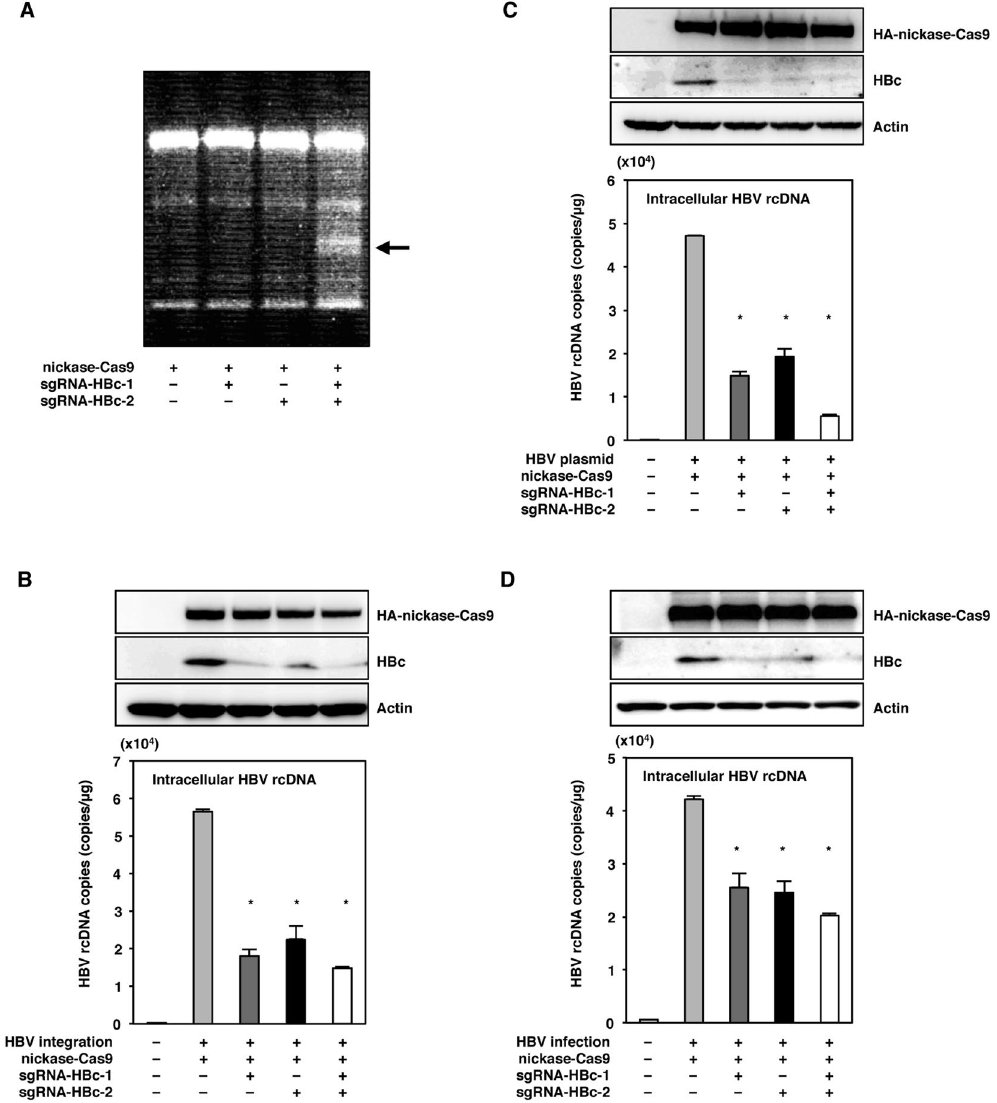
Figure 3. The expression of nickase-Cas9 with either or both of the sgRNAs suppressed the replication of HBV. ( A ) Nickase-Cas9 with sgRNA-HBc-1 and/or sgRNA-HBc2 was lentivirally transduced in HepG2.2.15.7 cells. Total DNA was collected at 5 days post-transduction, and mutations of HBV genome in HepG2.2.15.7 cells were detected by surveyor assay. The arrow indicated the surveyor digestion product. ( B ) HepG2.2.15.7 cells transduced with nickase-Cas9 and the sgRNAs were collected at 5 days post-transduction, and the expression of HBc was determined by immunoblotting. Intracellular HBV rcDNAs were extracted at 5 days post-transduction and quantified by qPCR. ( C ) Huh7 cells transduced with nickase-Cas9 and the sgRNAs were transfected with a plasmid containing 1.3-fold-overlength genome of HBV at 3 days post-transduction. Cell lysates were collected at 3 days post-transfection, and the expression of HBc was determined by immunoblotting. Intracellular HBV rcDNAs were extracted at 3 days post-transfection and quantified by qPCR. ( D ) HepG2-hNTCP-C4 cells expressing nickase-Cas9 and the sgRNAs by lentivirus vector were infected with HBV derived from the supernatants of HepAD38.7 cells at 3 days post-transduction. Cell lysates were collected at 10 days post- infection, and the expression of HBc protein was determined by immunoblotting. Intracellular HBV rcDNAs were extracted at 10 days post-infection and quantified by qPCR. * p < 0.01 vs. the results for control cells. (full- length gels are presented in Supplementary